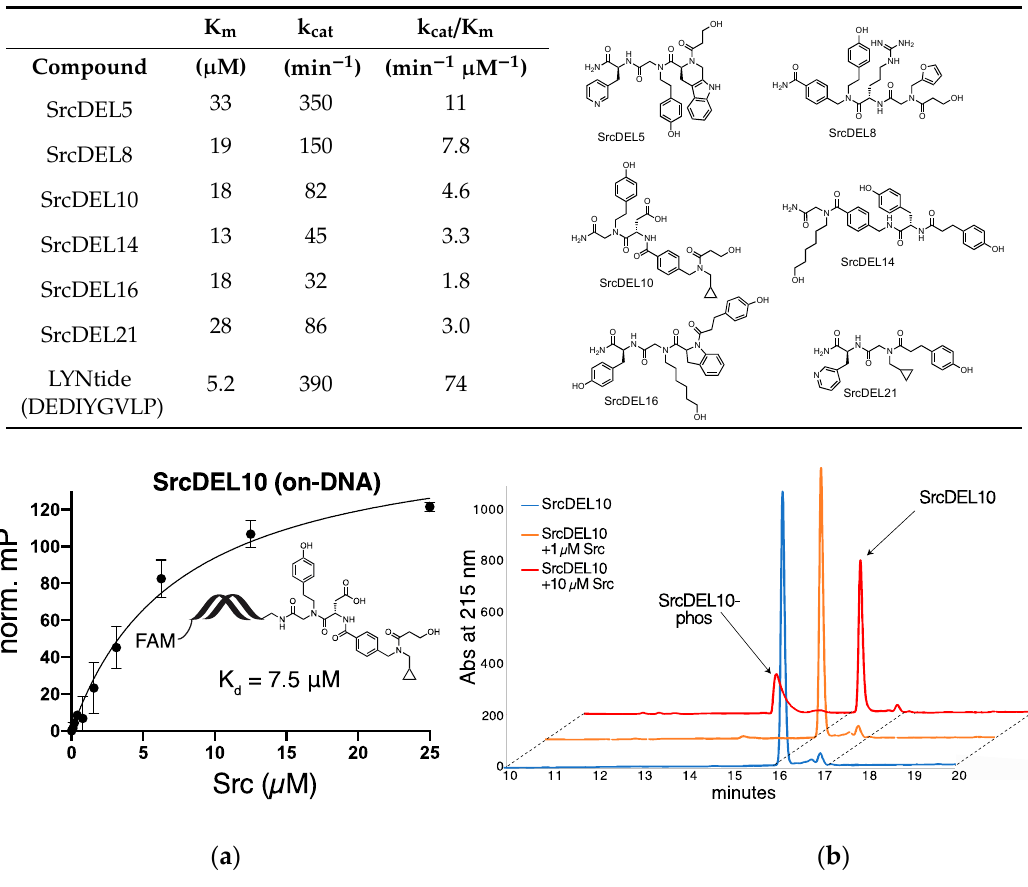
Figure 3. Validation of SrcDEL10 as a hit molecule from the substrate-mediated selection. ( a ) on-DNA binding affinity to c-Src measured by fluorescence polarization in the presence of ATP (100 µM). A SrcDEL10 modified oligo was hybridized to a fluorescein amide (FAM) modified complementary oligo for the binding assay. ( b ) Off-DNA HPLC analysis of SrcDEL10 (200 µM) with treatment of ATP (1 mM) and c-Src at high levels (1 µM, yellow, and 10 µM, red), which gave small amounts of the phosphorylated molecule. Peak identity was verified by LC/MS analysis (Figure S9).